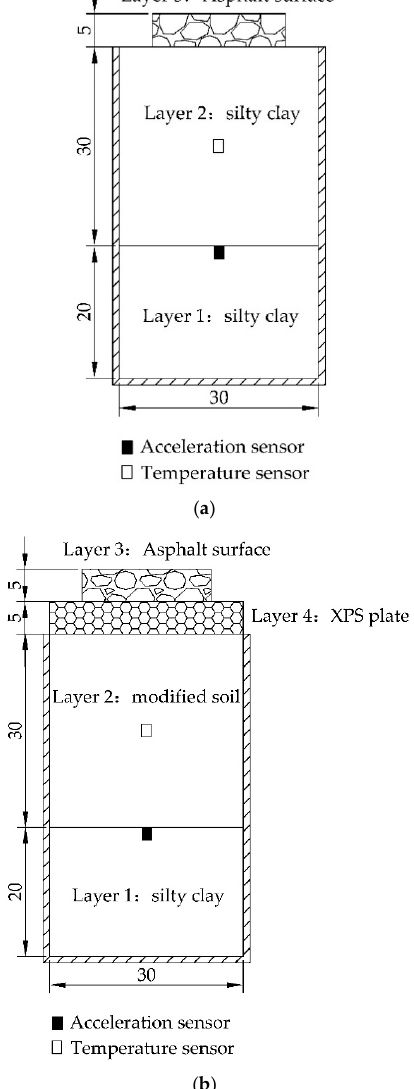
Figure 3. Diagram of sensors and filling materials of the two test groups. ( a ) G1; ( b ) G3.